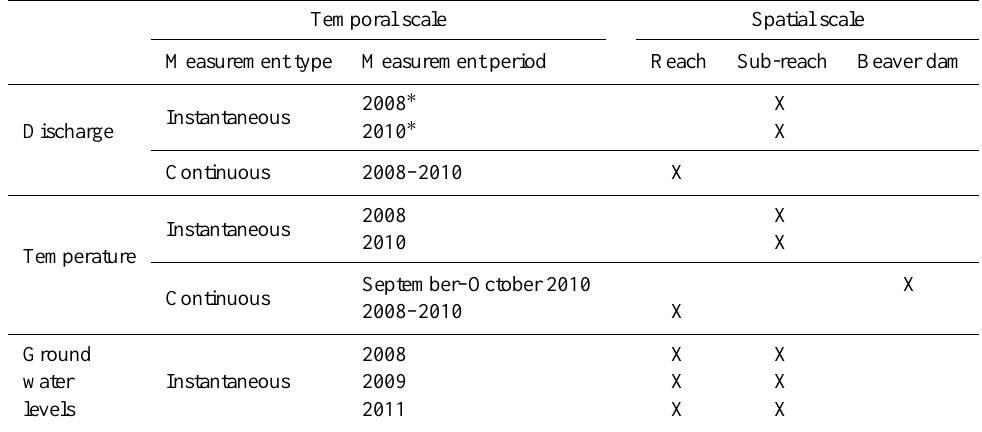
Table 1. Discharge, temperature, and ground water level observations made at different spatial and temporal scales throughout the study